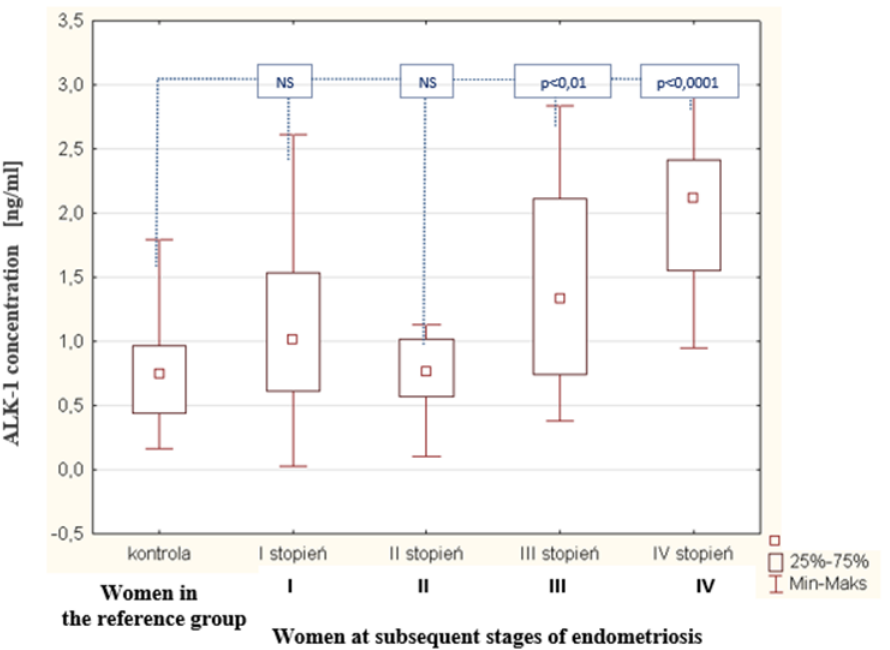
Figure 6. ALK-1 concentration in the peritoneal fluid of women at subsequent stages of endometriosis and women in the reference group.